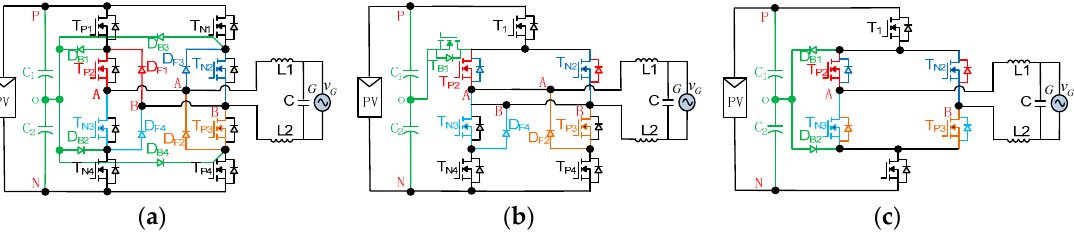
Figure 23. Inverter topologies with the Direct Connection NPC cell under DFUSPWM. ( a ) R11S1 (new); ( b ) R12S1 (new); ( c ) R13S1 (new).